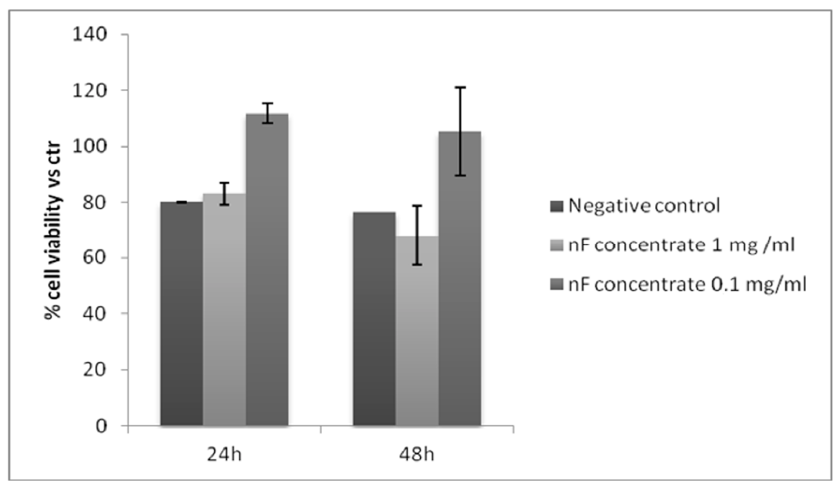
Figure 11. MTT assay for each concentration of the NF concentrate after 24 h and 48 h of treatment.